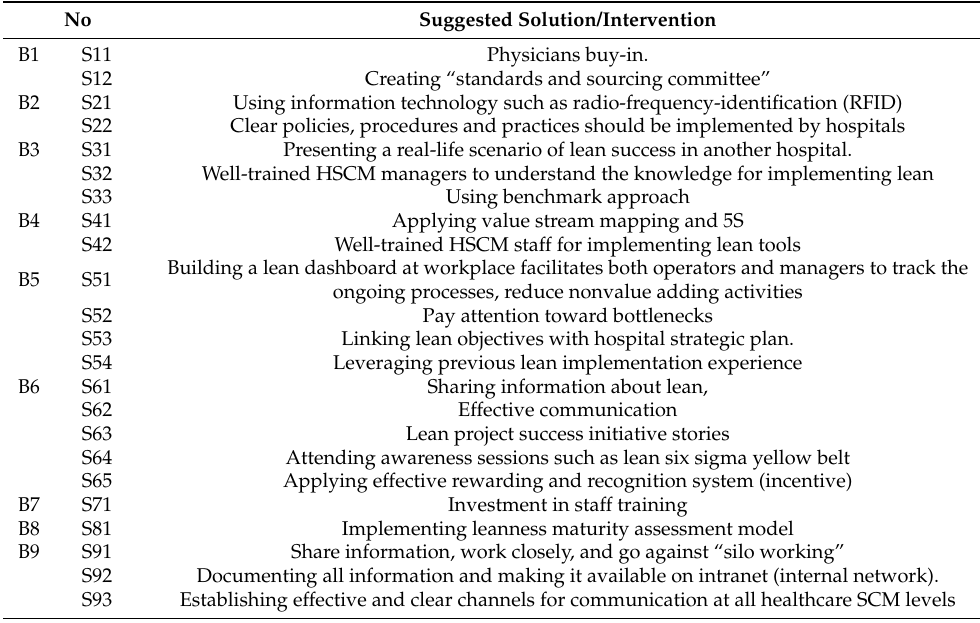
Table 3. Suggested Solutions to overcome